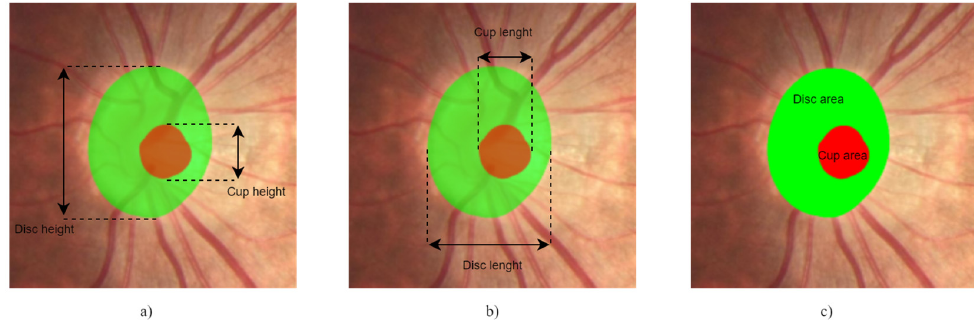
Figure 3. CDR: ( a ) VCDR; ( b ) HCDR; ( c ) ACDR. Different parameters can be measured for the CDR to determine the cupping and assess the eye for the presence of glaucoma, such as the horizontal cup diameter to the horizontal OD diameter, the vertical cup disc diameter to the vertical OD diameter and the area of the cup to the area of the OD [19]. If the vertical CDR (VCDR) and horizontal CDR (HCDR) are more than 0.5, the eye is considered to be at risk of abnormality; other-